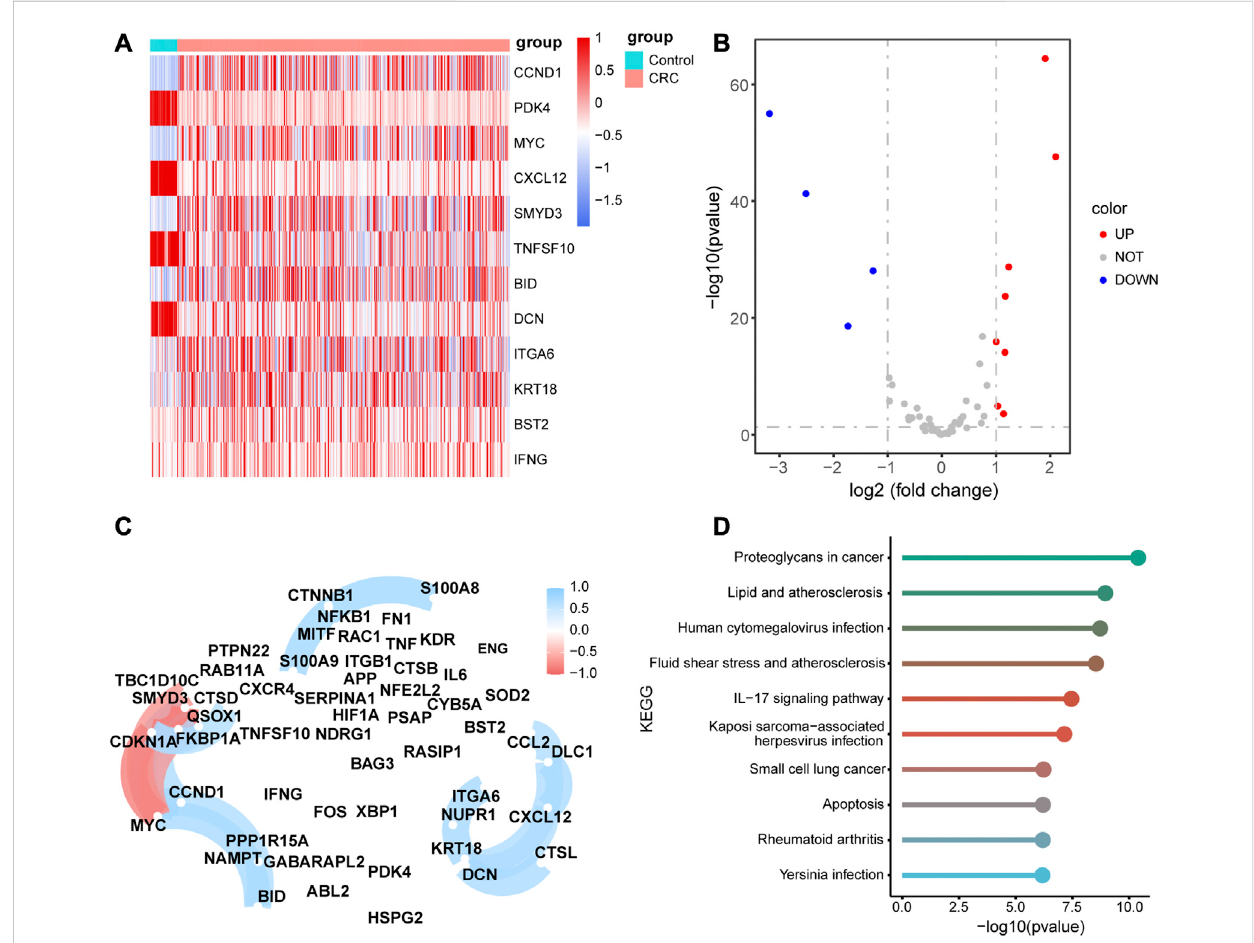
FIGURE 5 Differential, correlation, and signal pathway enrichment analysis of the 55 autophagy-related genes (ARGs) (A) Heatmap of the differential expression levels of11 ARGs expression levels between colorectal cancer (CRC) and normal adjacent tissues. (B) Volcanic plot of the differential expression ARGs between CRC and normal adjacent tissues. (C) Correlation network diagram of the 55 ARGs. The red color represents a positive correlation and blue color represents a negative correlation. (D) Top 10 enriched metabolic pathway of the 55